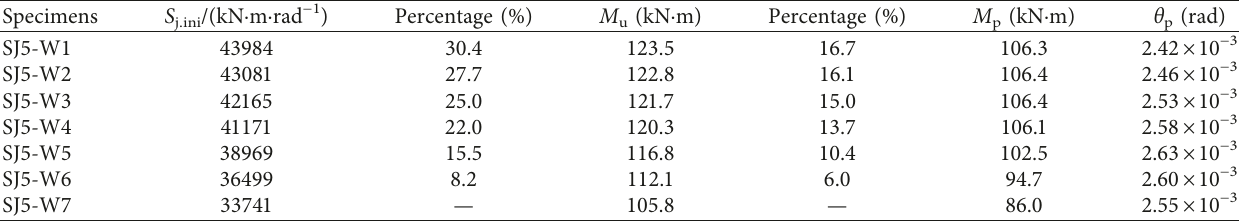
Table 6: Percentage change of characteristic quantities of initial stiffness and plastic moment resistance with different weld lengths between the gusset plate and beam flange.